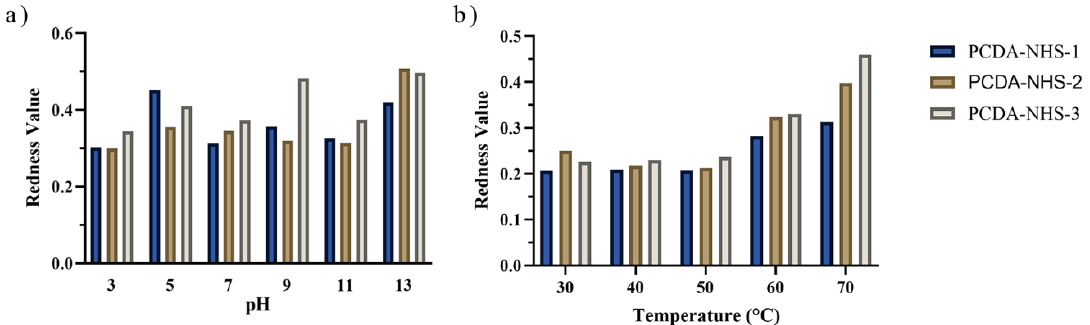
Figure 4. Effect of pH and temperature on redness value. Sensors from each PCDA-NHS group were exposed to solutions of various pH ( a ) and were also exposed to various temperatures ( b ).